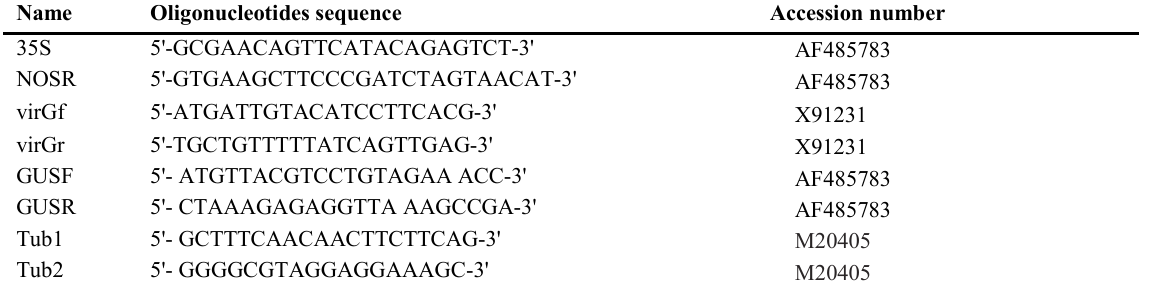
Table 1. Oligonucleotides (primers) used in PCR and RT-PCR. The name and the sequences of each primer were